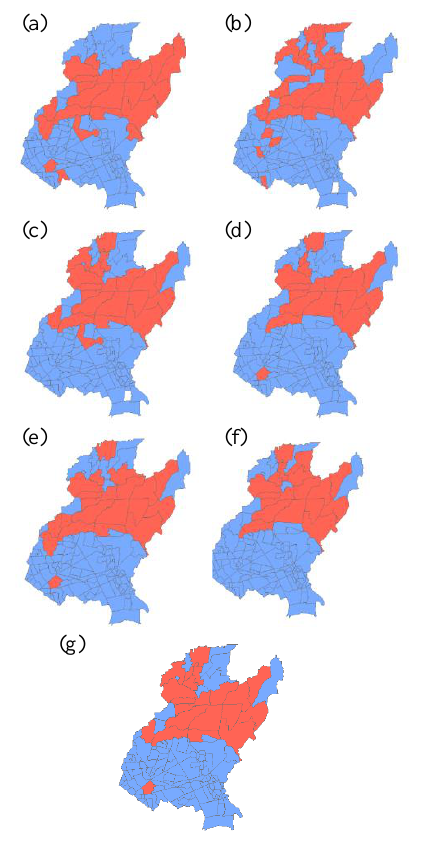
Figure 5. Clusters identified using ArcMap Grouping Analysis. (a) 2010 (b) 2011 (c) 2012 (d) 2013 (e) 2014 (f) 2015 (g) 2010 -